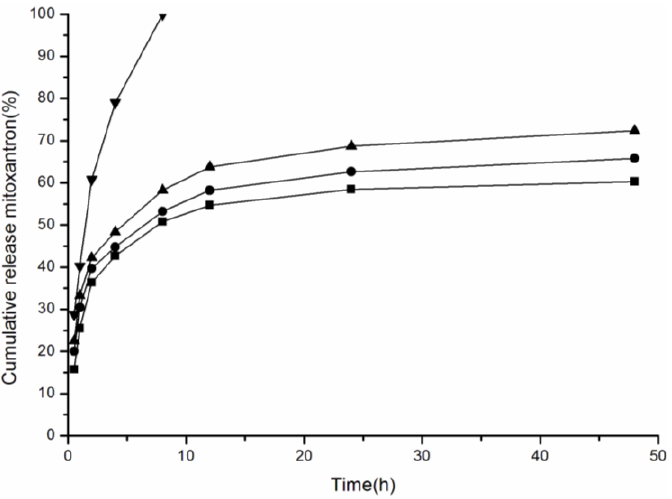
Figure 5. The mitoxantrone (MTO) release of nanoparticles in phosphate buffered saline (PBS) at 37 °C in vitro ( ▼ free mitoxantrone, ■ CHP, ● CHCP, ▲ CHAP).